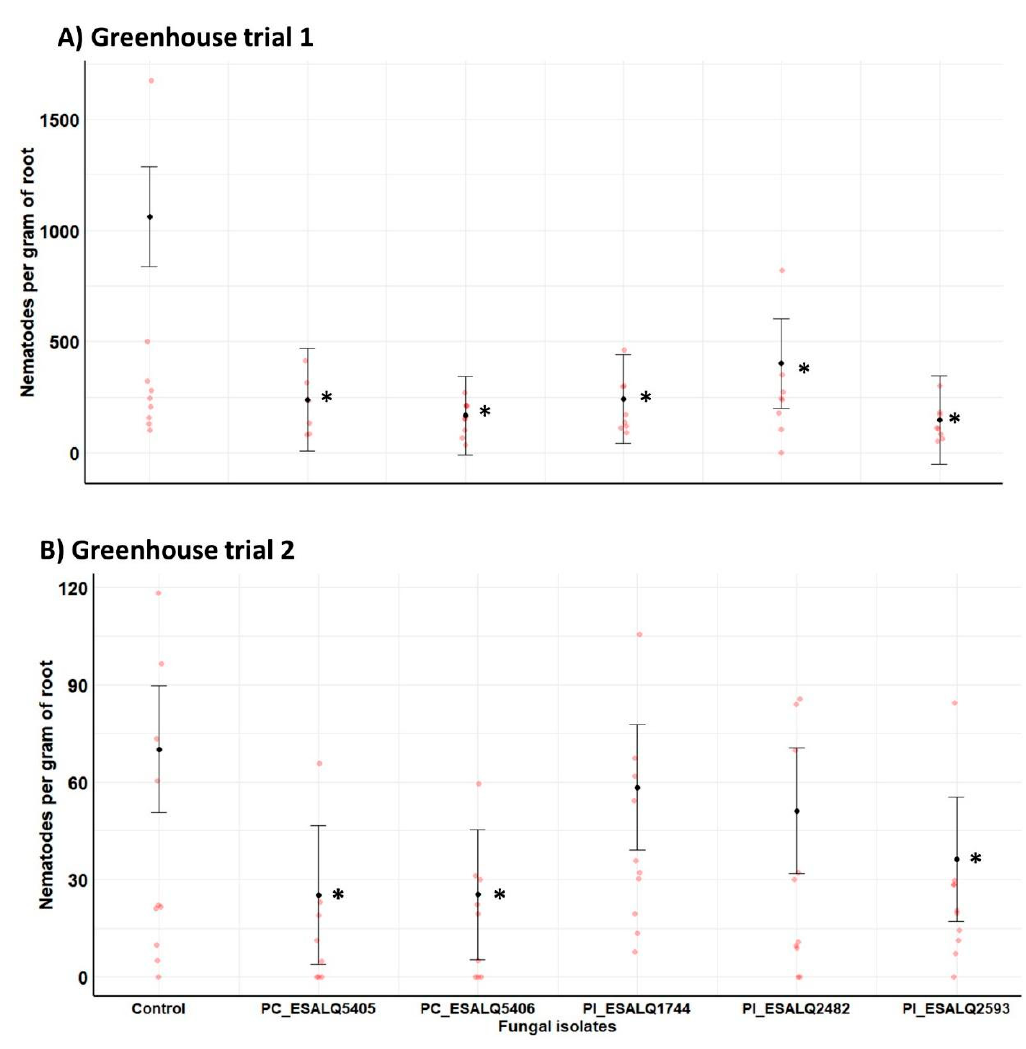
Figure 7. Impact of Purpureocillium lilacinum (Pl) and Pochonia chlamydosporia (PC) isolates on the population density (nematodes per gram of fresh root mass) of the soybean cyst nematode Heterodera glycines from potted bean plants at 45 days after fungal inoculation and seeding, under greenhouse conditions. Means with 95% confidence intervals ( n = 10 plants per treatment in red symbol) followed by asterisks (*) are significantly different from untreated control plants infested only with the nematode (Likelihood ratio test at p < 0.05).